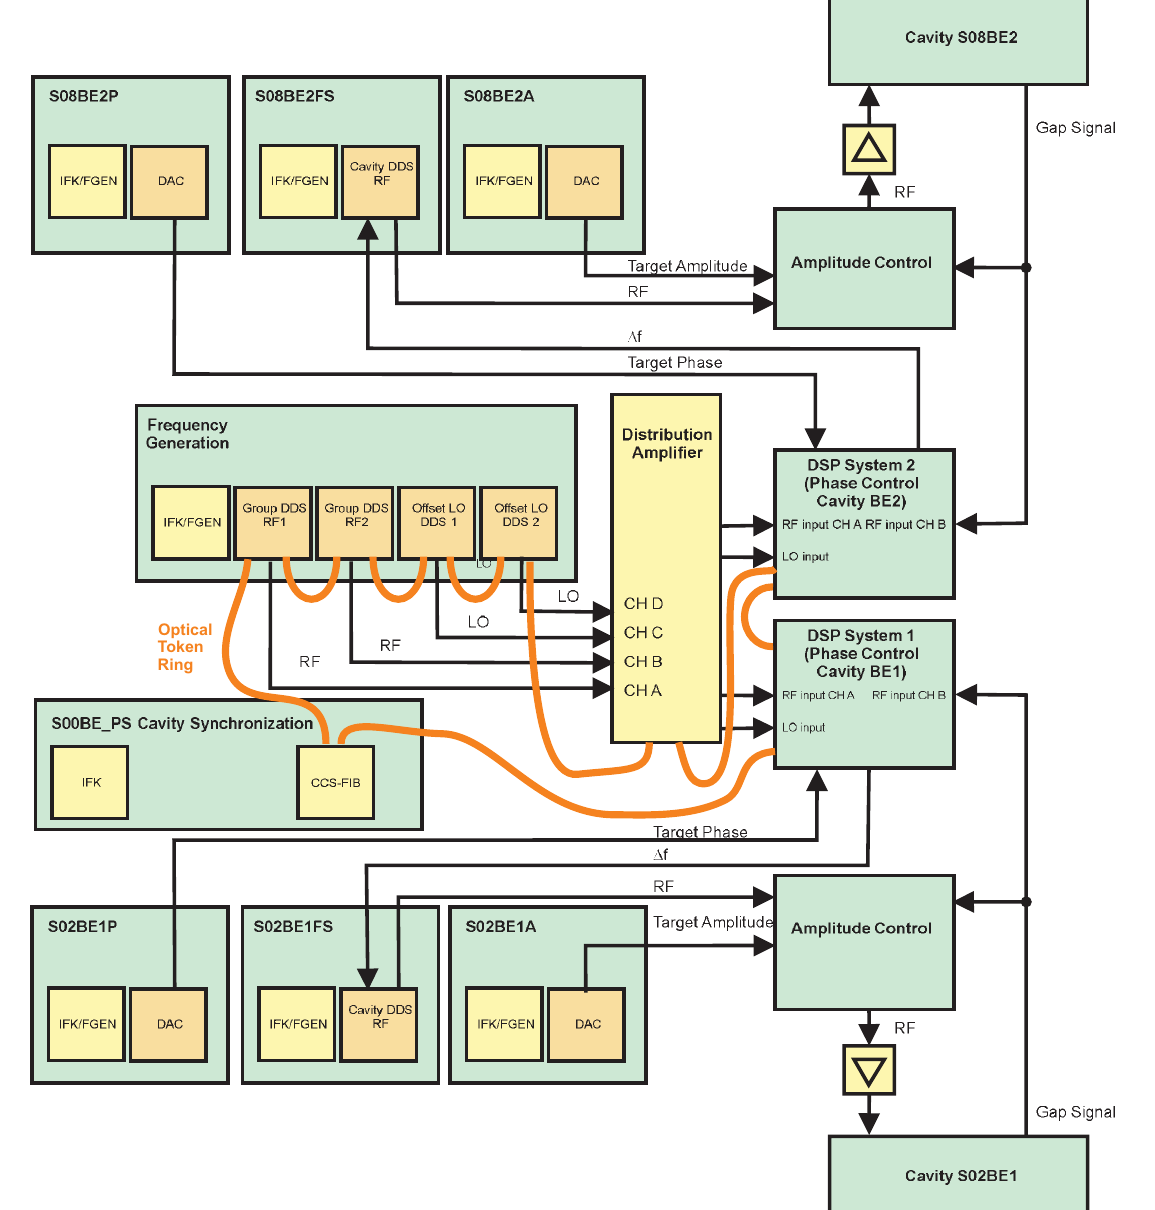
FIG. 3. Block diagram of SIS18 LLRF